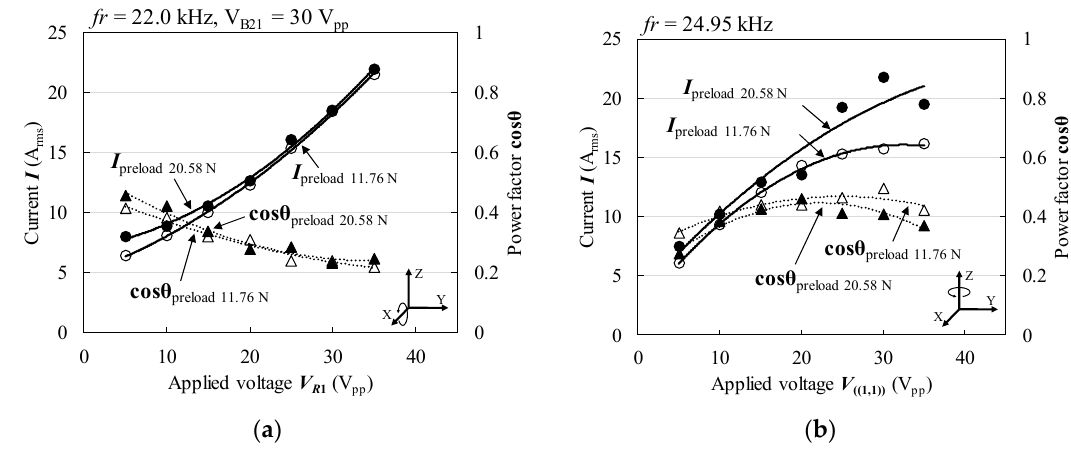
Figure 17. Effective current and power factor with respect to applied voltage. ( a ) Rotation around X(Y)-axis and ( b ) Rotation around Z-axis.